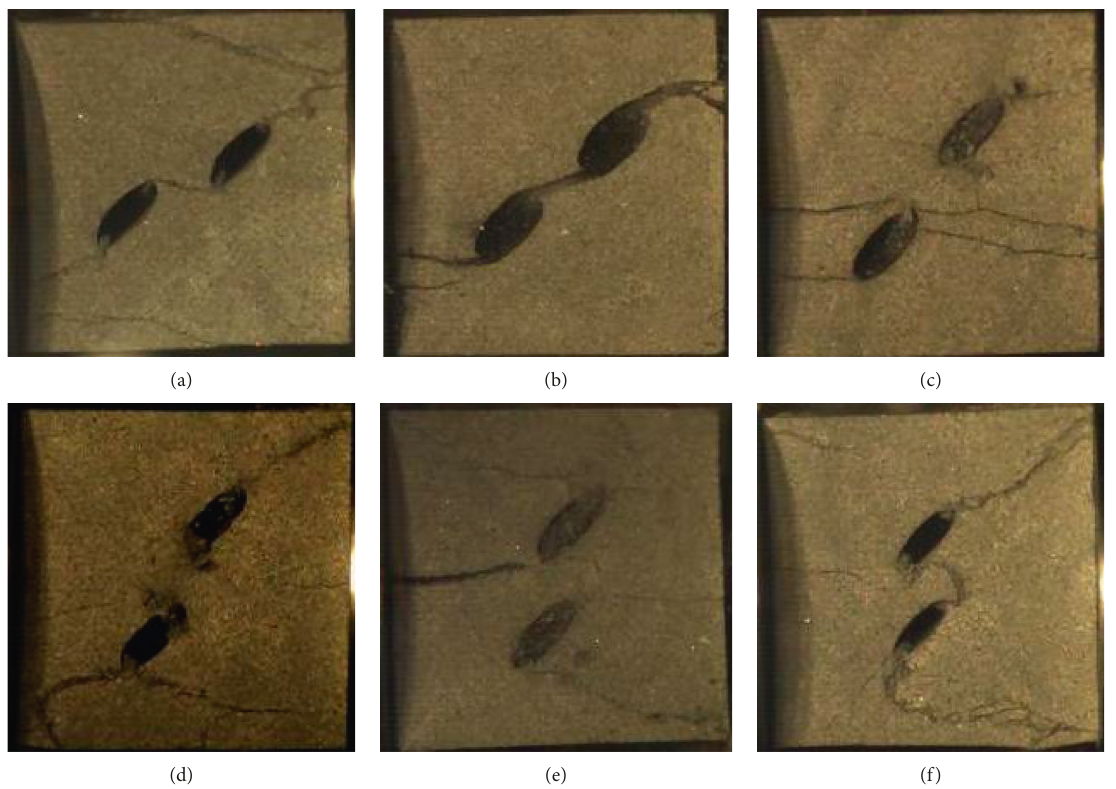
Figure 14: Effect of the ligament angle on the final failure patterns of defected sandstone specimens under dynamic loading. (a) S-45-0. (b) S-45-30. (c) S-45-60. (d) S-45-90. (e) S-45-120. (f)